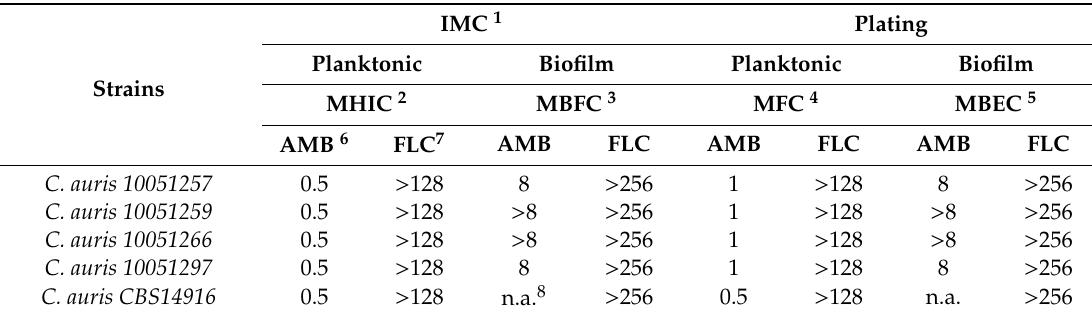
Table 4. Values of MHIC, MBFC, MFC, and MBEC ( µ g / mL) of amphotericin B and fluconazole against planktonic and biofilm C. auris